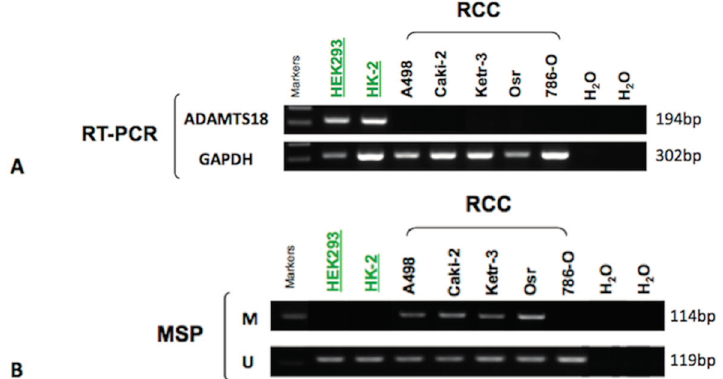
Figure 1. Analysis of the ADAMTS18 gene in various cell lines. ( A ) ADAMTS18 gene expression was detected in the normal cell lines HEK293 and HK-2 by RT-PCR; GAPDH served as the control; and ( B ) ADAMTS18 gene hypermethylation was detected in the ccRCC-derived cell lines A498, Caki-2, Ketr-3 and Osr by MSP; It was unmethylated in normal cell lines. M, methylated; U,